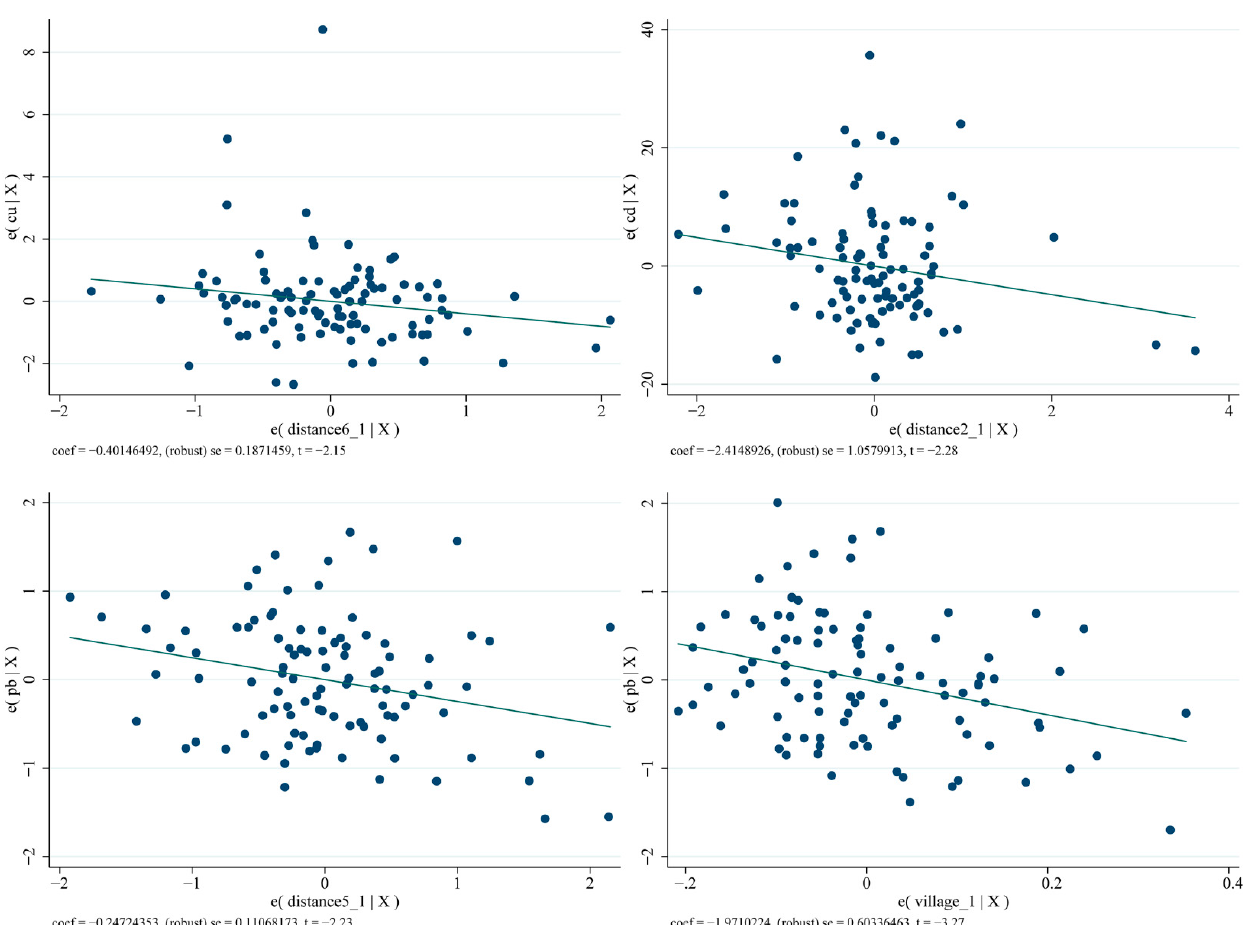
Figure 4. The results of the multiple regression model.